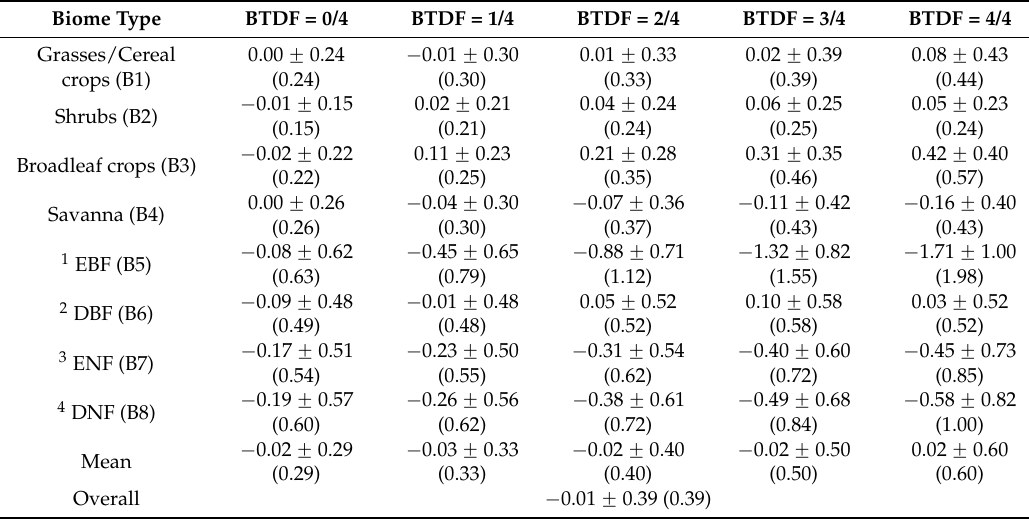
Table 1. Biome specific differences between C5 and C6 LAI at the global scale in 2003. Mean value and standard deviation of the difference and RMSE (values in brackets) between C5 and C6 (C6 minus C5) are listed in the